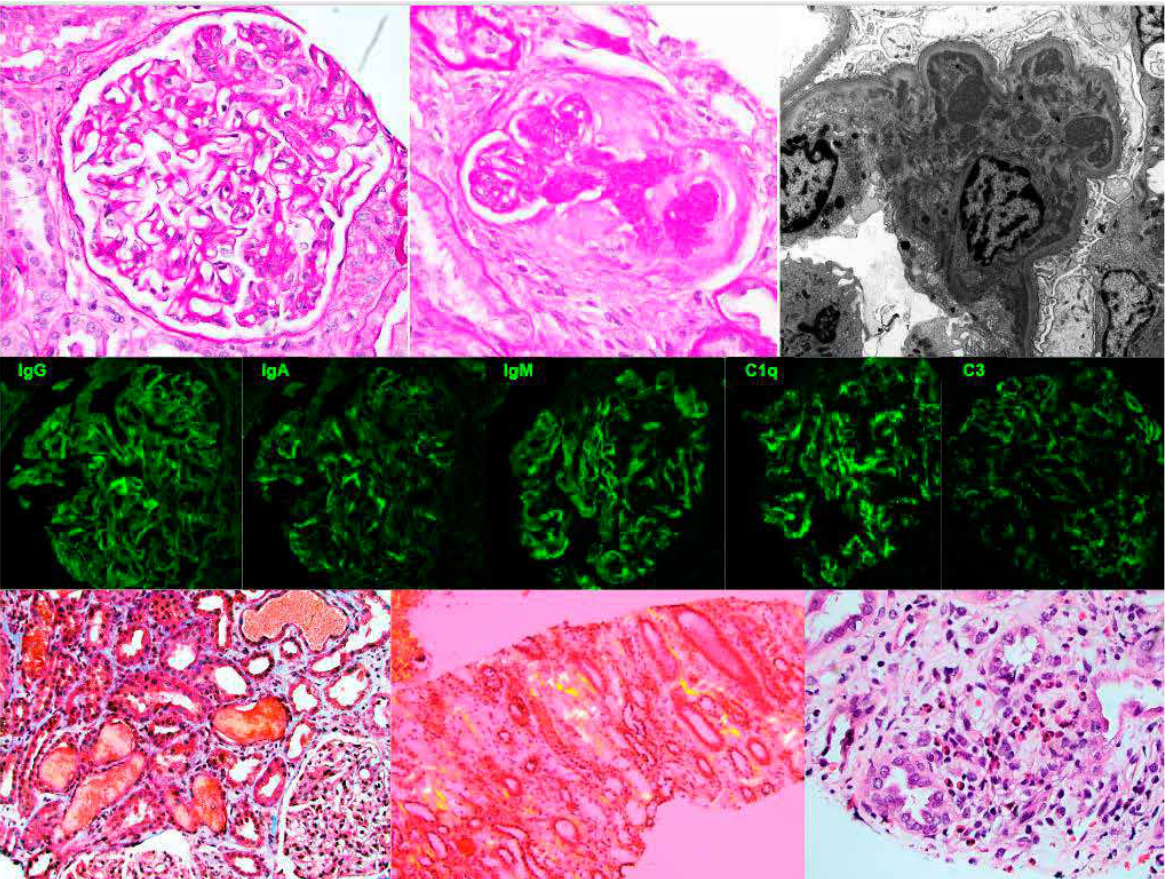
Figure 1: Renal biopsy findings. Membranoproliferative glomerulonephritis showing (top row-left) segmental endocapillary hypercellularity and double contour formation (top-row-middle) old fibrous crescent by light microscopy (periodic acid schiff stain) and (top-row-right) mesangial and subendothelial immune complex deposits by electron microscopy. (Middle-row) representative micrographs of the immunofluorescence studies. Additional tubulointerstitial findings included (bottom-row-left) numerous occlusive red blood cell casts in the tubules (trichrome stain) (bottom-row-middle) interstitial amyloidosis showing apple-green birefringence on congo red stain (bottom-row-right) numerous interstitial eosinophils suggestive of allergic/drug-induced acute interstitial nephritis (H&E